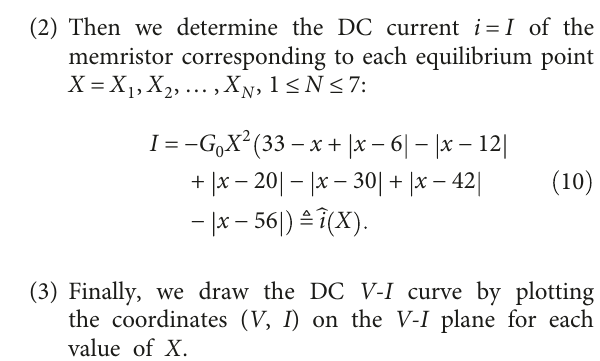
. The horizontal dotted lines are the separatrices and pass through , Q , Q , and Q 1 3 5 7 , Q , and Q , 2 4 6